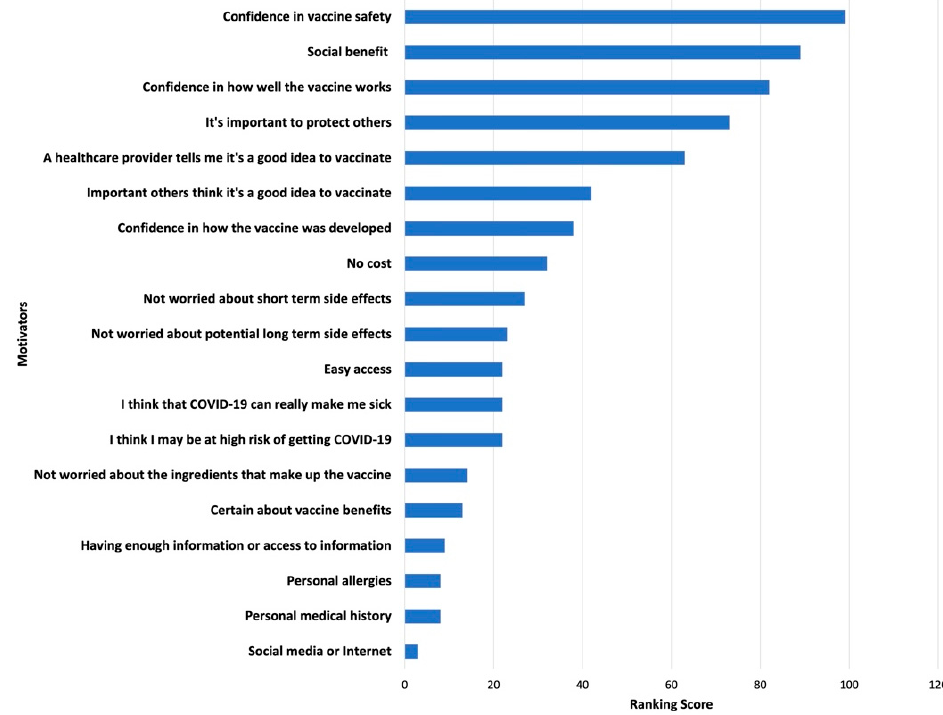
Figure 3. Top Parental Motivators for Vaccinating Adolescents against COVID-19.